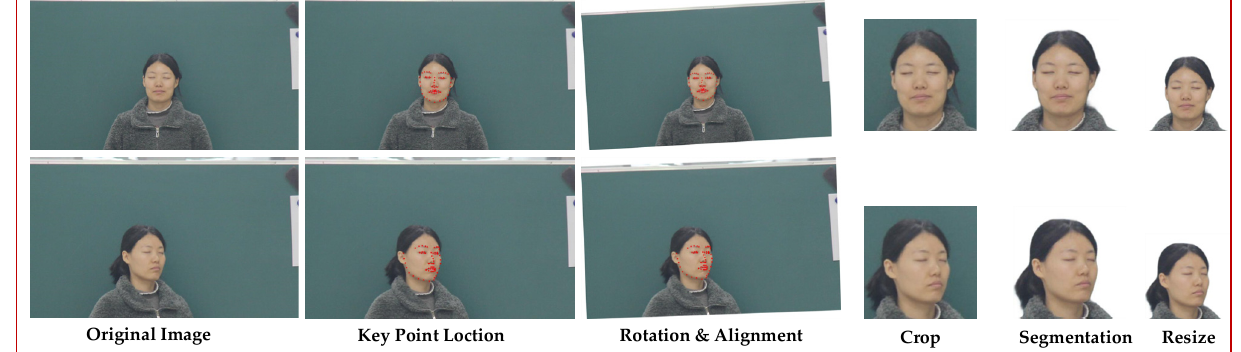
Figure 5. Dataset preprocessing process.